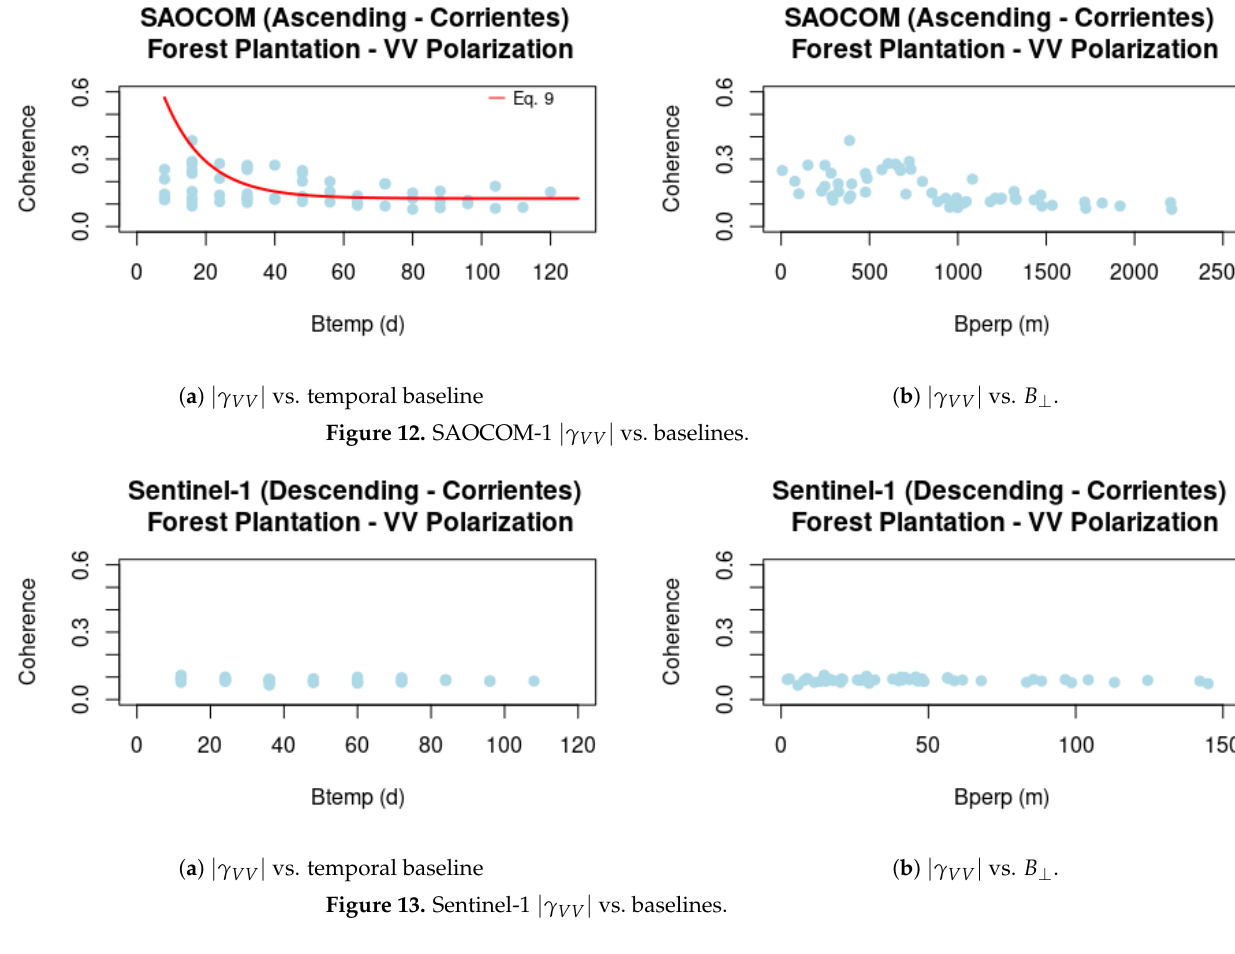
Figure 13. Sentinel-1 | γ VV | vs.